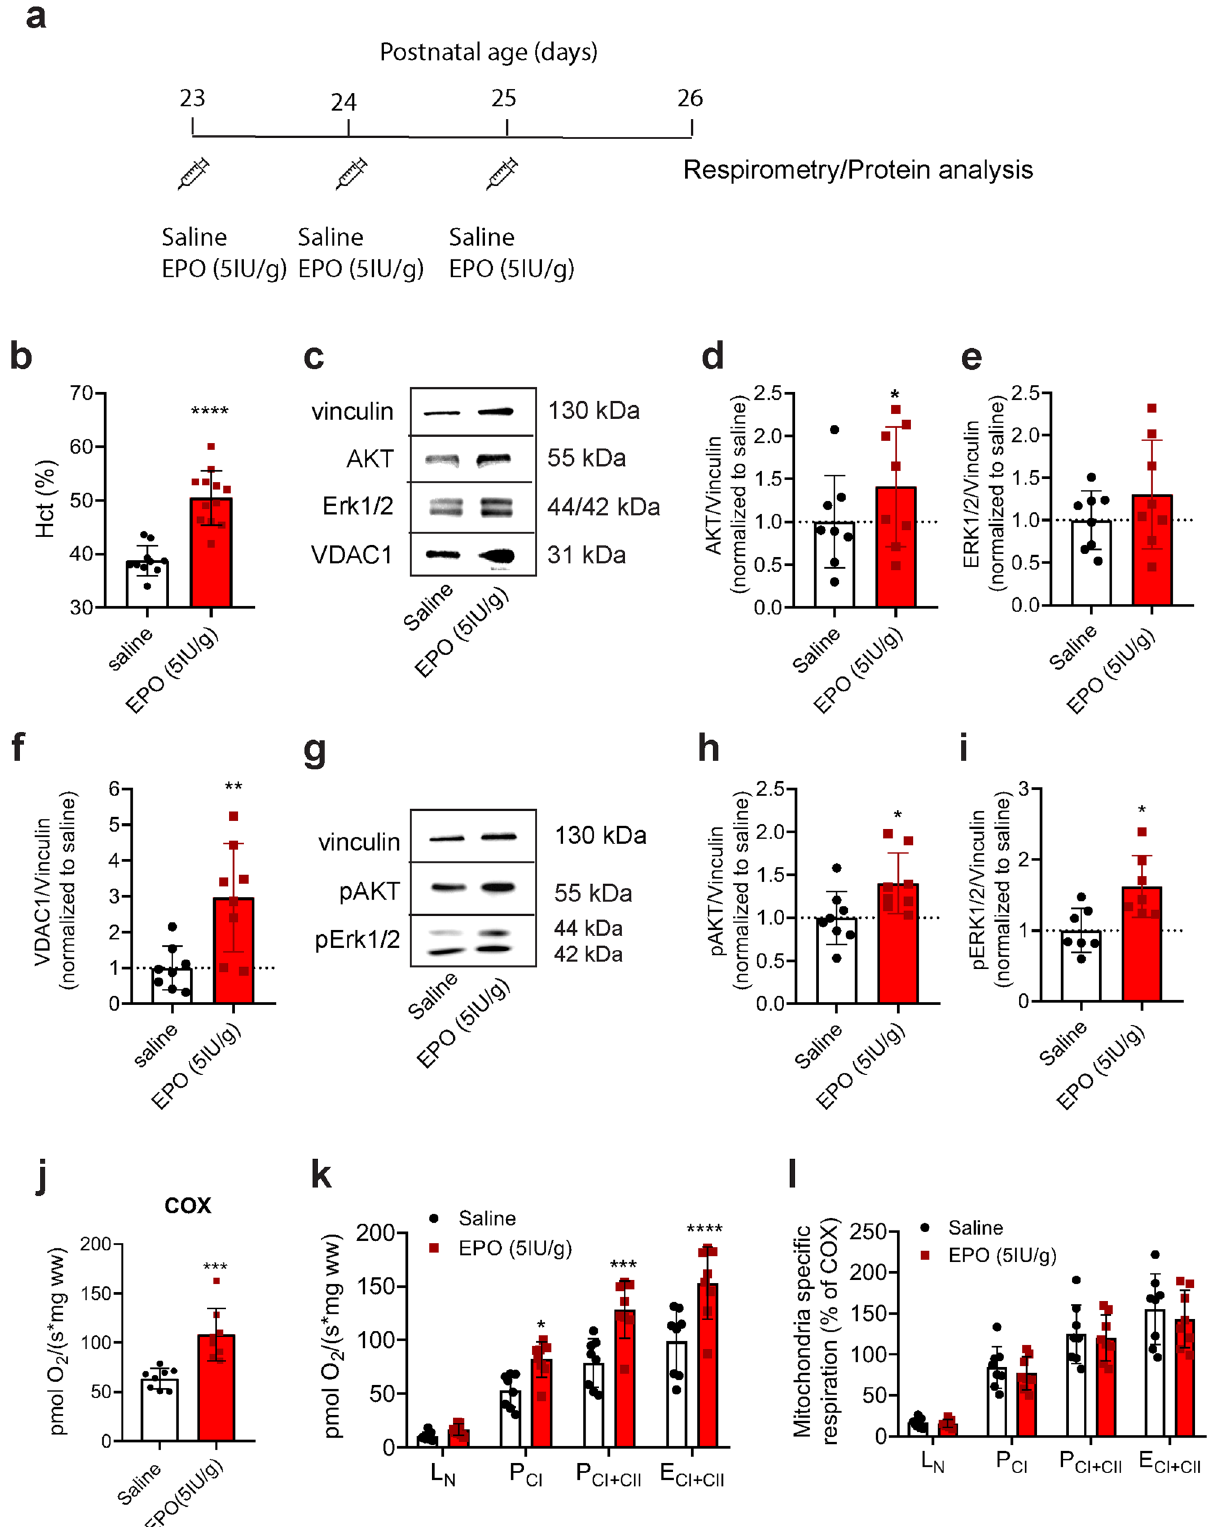
(2-way ANOVA, F (1,22) = 12.1, p < 0.01; Fig. 7a lower middle panel), and faster swim speed (2-way ANOVA, F (1,22) = 18.56, p < 0.0001; Fig. 7a lower right panel) when fi nding the new hidden platform location. These results suggest that Tg21 mice have improved spatial learning and memory compared to WT